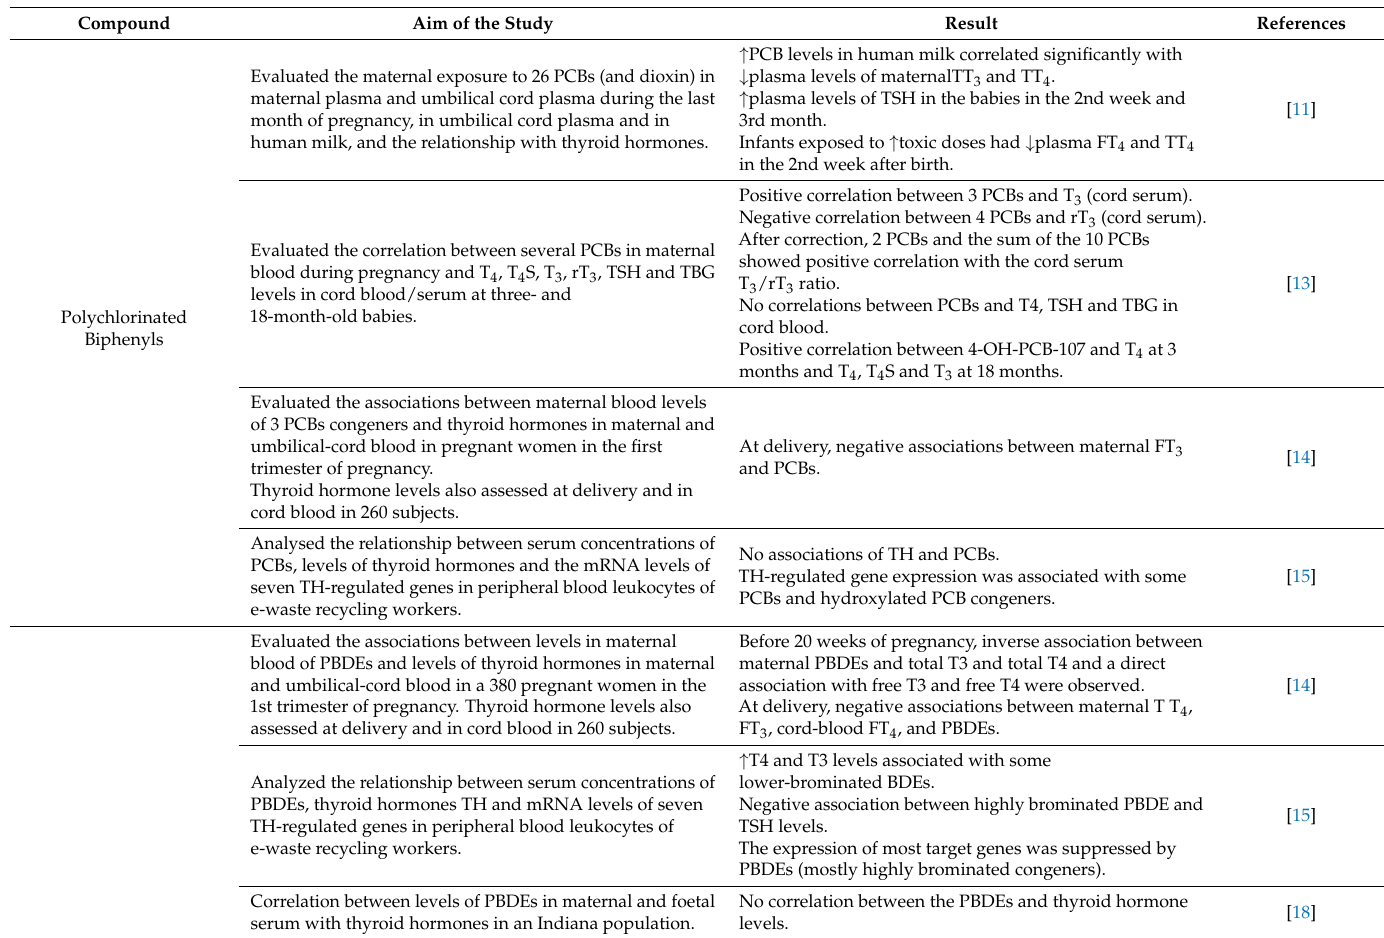
Table 1. Major studies on industrial chemicals and main results